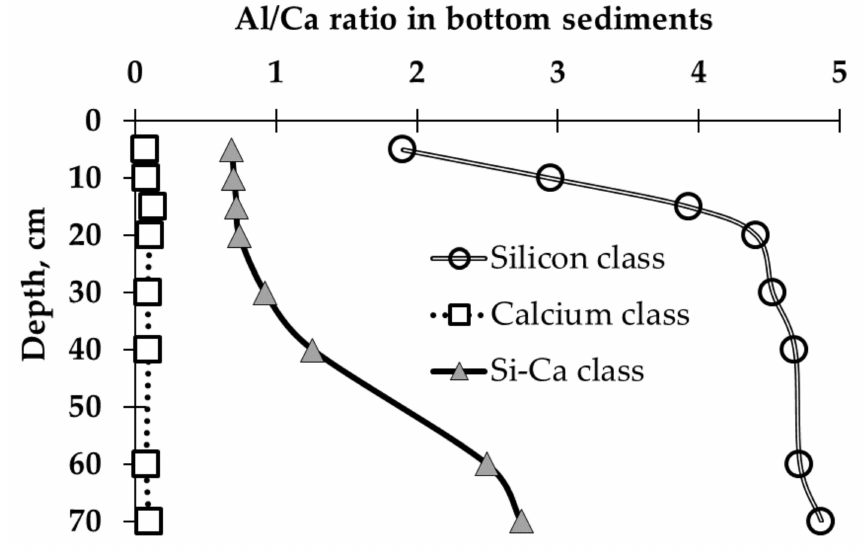
Figure 10. Vertical distribution of the Al / Ca ratio by depth for silicon, calcium, and mixed classes of bottom sediments of small lakes in the south of Western